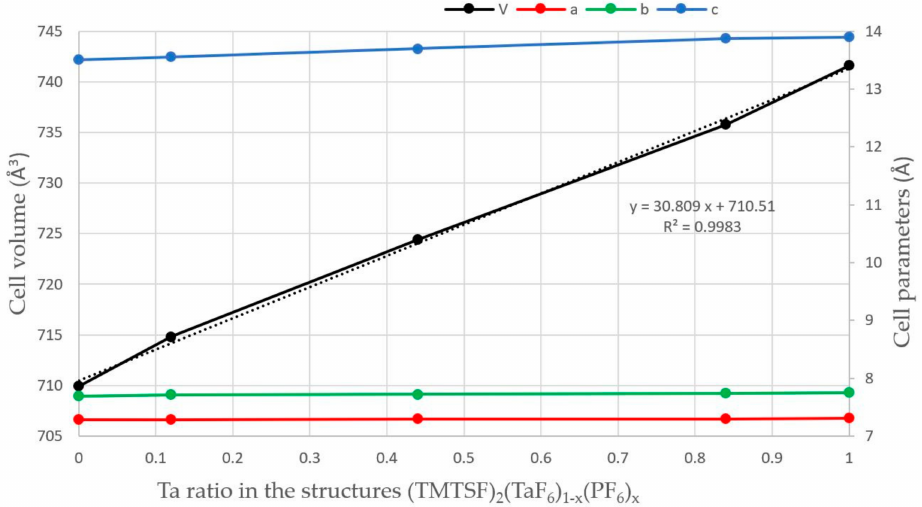
Figure 2. Variation of the cell parameters a (red), b (green), c (blue) (Å) and cell volume (Å 3 ) (black) in the structures (TMTSF) 2 (TaF 6 ) 1 − x (PF 6 ) x . The black dotted line is the linear regression curve for the variation of the cell